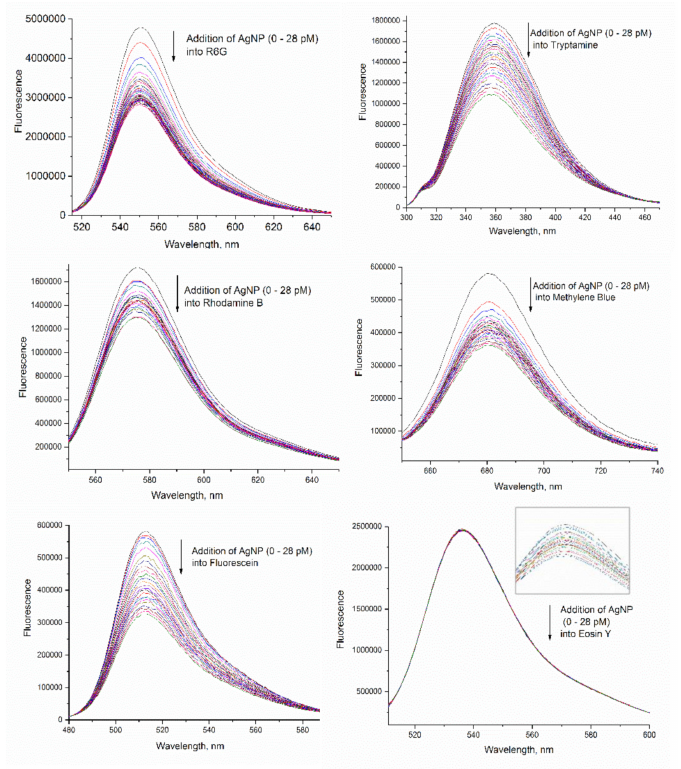
Figure 1. Fluorescence quenching of 1 µ M dye solutions upon addition of various amounts of 240 pM AgNP. The insert for eosin Y shows the enlarged detail of fluorescence peaks, where comparatively weak quenching is